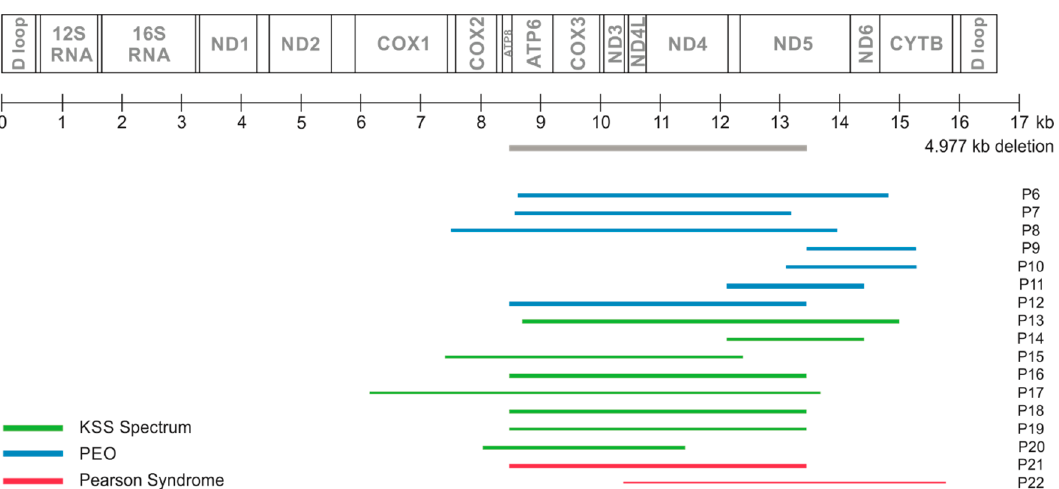
Figure 1. Molecular-genetic data characterizations of SLSMD in muscle of 17 patients. Colour of bars correspond with phenotypic group, thickness of the bars corresponds with heteroplasmy level. The exact lengths and heteroplasmy levels were as follows: P6—6193 bp, 72%; P7—4616 bp, 66%, P8—6457 bb, 58%; P9—1835 bp, 59%; P10—2184 bp, 57%; P11—2298 bp, 91%; P12—4961 bp, 78.5%; P13—6302 bp, 68%; P14—2298 bp, 56%; P15—4978 bp, 46%; P16—4963 bp, 76%; P17—7535 bp, 39%; P18—4963 bp, 64%; P19—4963 bp, 46%; P20—3387 bp, 60%; P21—4963 bp, 71%; P22—5395 bp, 30%. For clarity, the 4.977 kb mtDNA deletion (e.g., common deletion) is included at heteroplasmy 100%